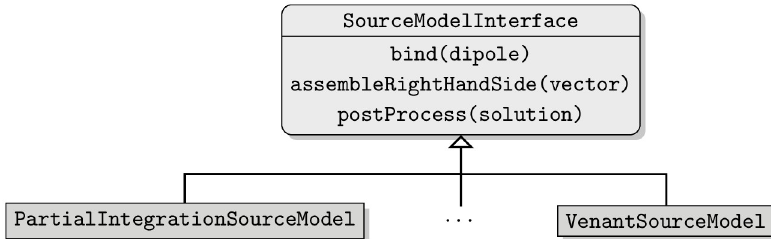
Fig 2. DUNEuro source model interface diagram. The structure of the source model interface and its